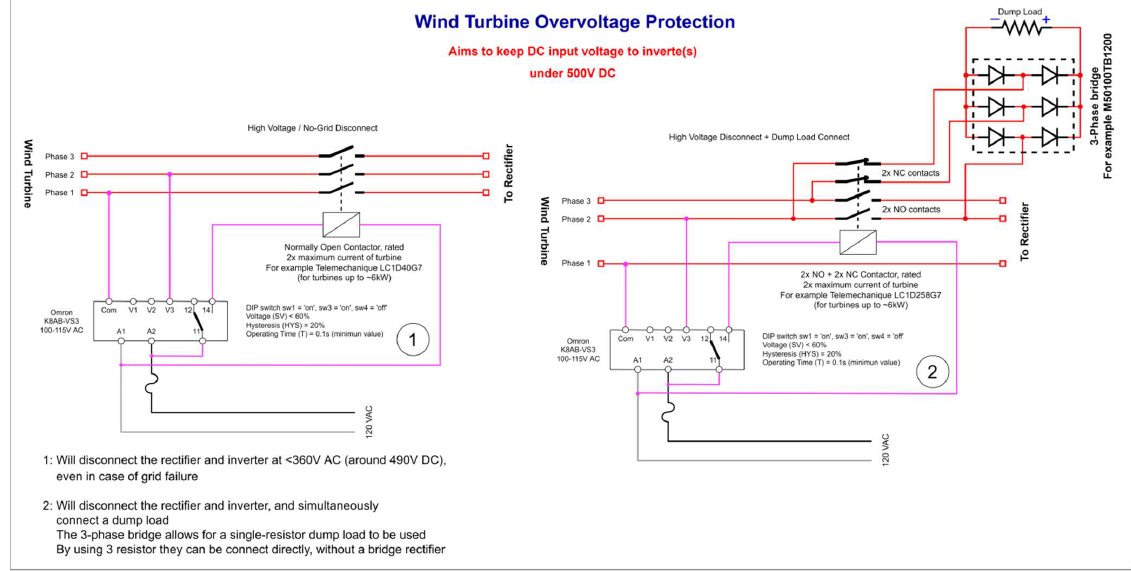
Figure 13. General Purpose Surge Protection System